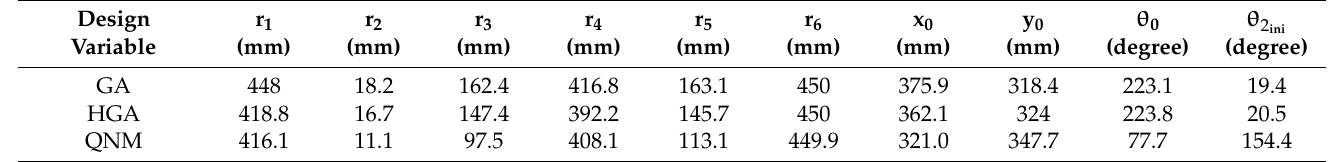
Table 4. Final results of the synthesized mechanisms.